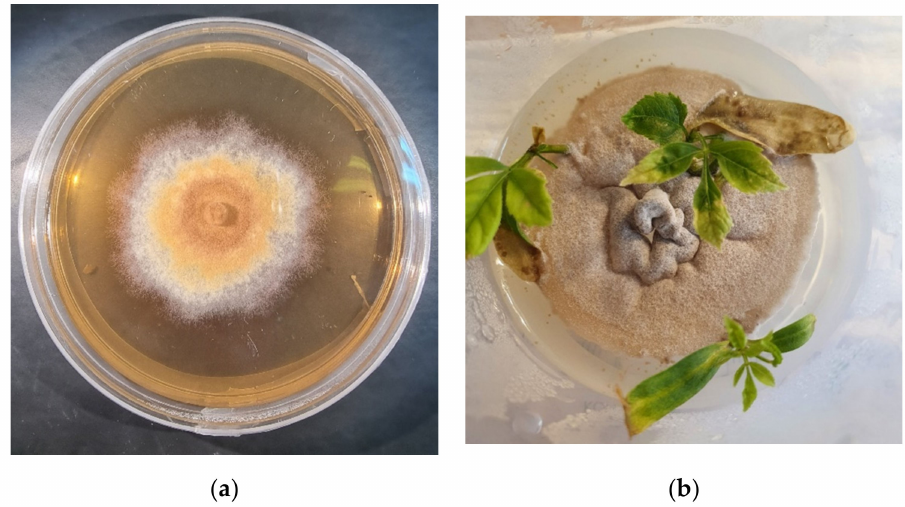
Figure 2. Fungus Hymenoscyphus fraxineus : ( a ) In a pure culture on maltose nutrient medium; ( b ) with ash microshoots post